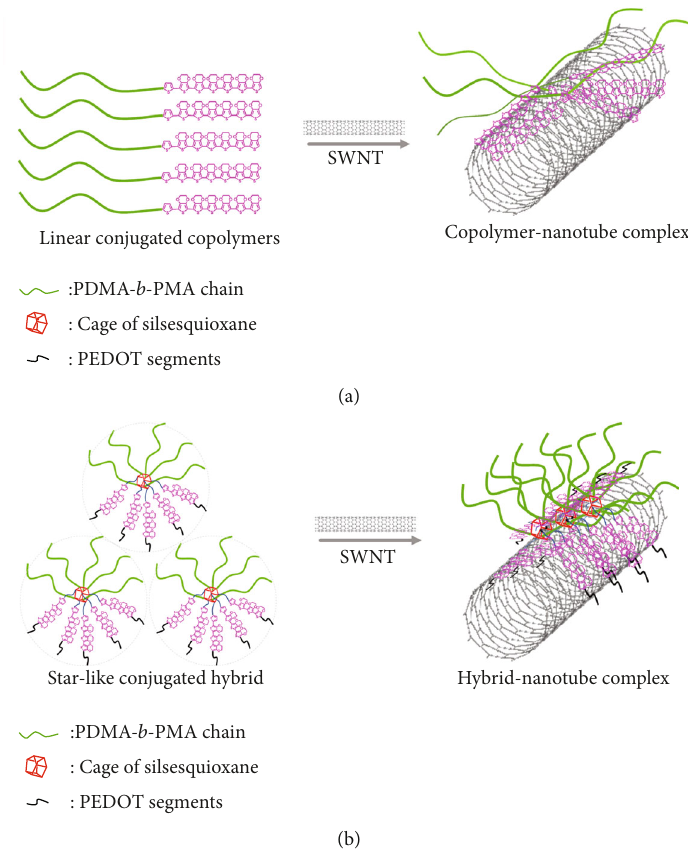
Figure 5: Mechanism between SWNTs with modi fi